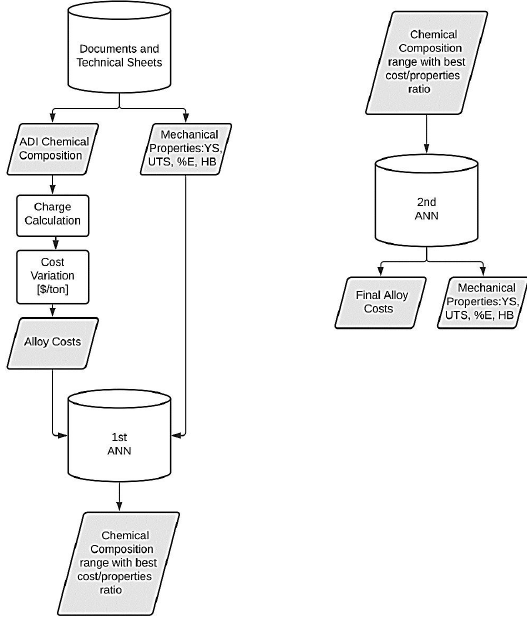
Figure 1. Flowchart showing the two ANNs of this work.